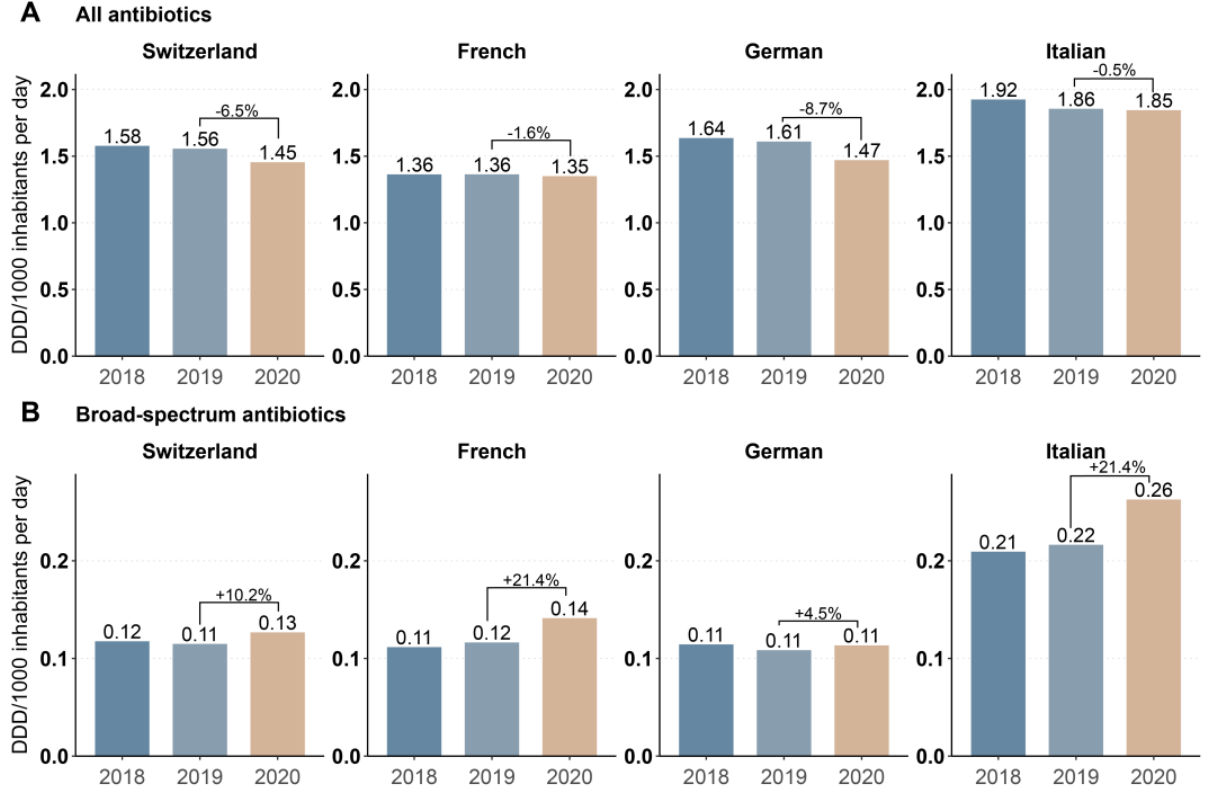
Figure 2. Annual antibiotic sales expressed in DDD per 1000 inhabitants per day for ( A ) antibiotics for systemic use (ATC code J01) and ( B ) broad-spectrum antibiotics in Switzerland and the three linguistic regions between 2018–2020. Data source: IQVIA sales data (Sell-in) from pharmaceutical industries to hospital sector.